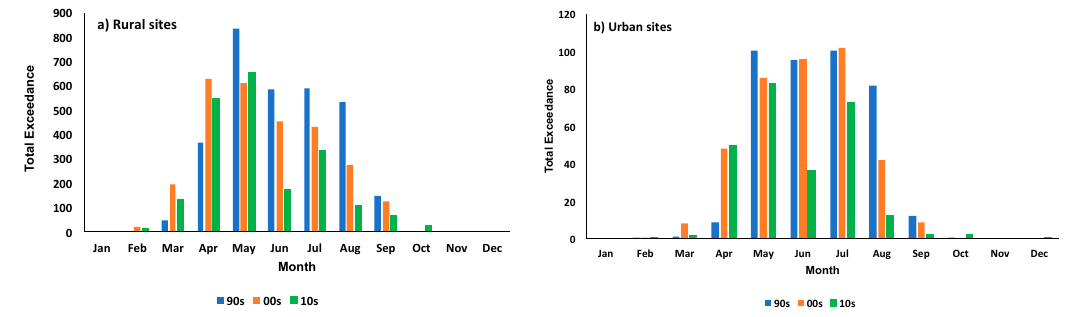
Figure 4. Seasonal total ozone exceedances in ( a ) rural and ( b ) urban sites averaged for the decades of the 1990s, 2000s and 2010s. Total exceedance is calculated as the total number of hours at an ozone concentration ≥ 50 ppbv for each month in a year, yearly averaged for each decade.